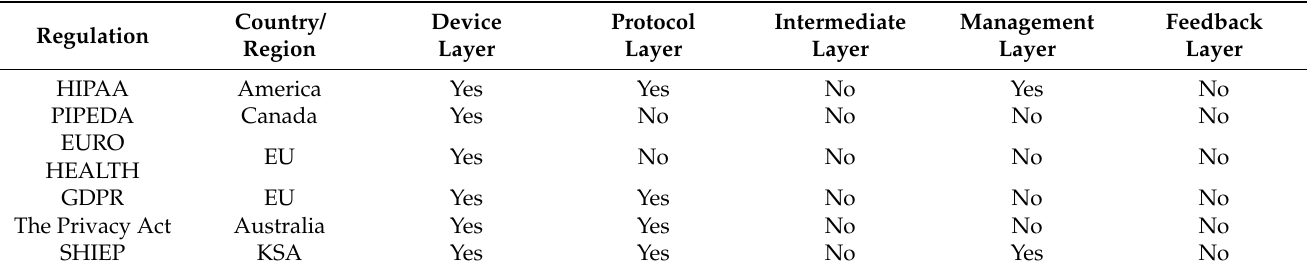
Table 4. Comparison of Healthcare